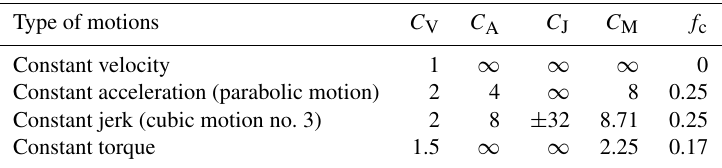
Table 1. Characteristic values of conventional motion programs. Type of motions C V C A C J C M Constant velocity Constant acceleration (parabolic